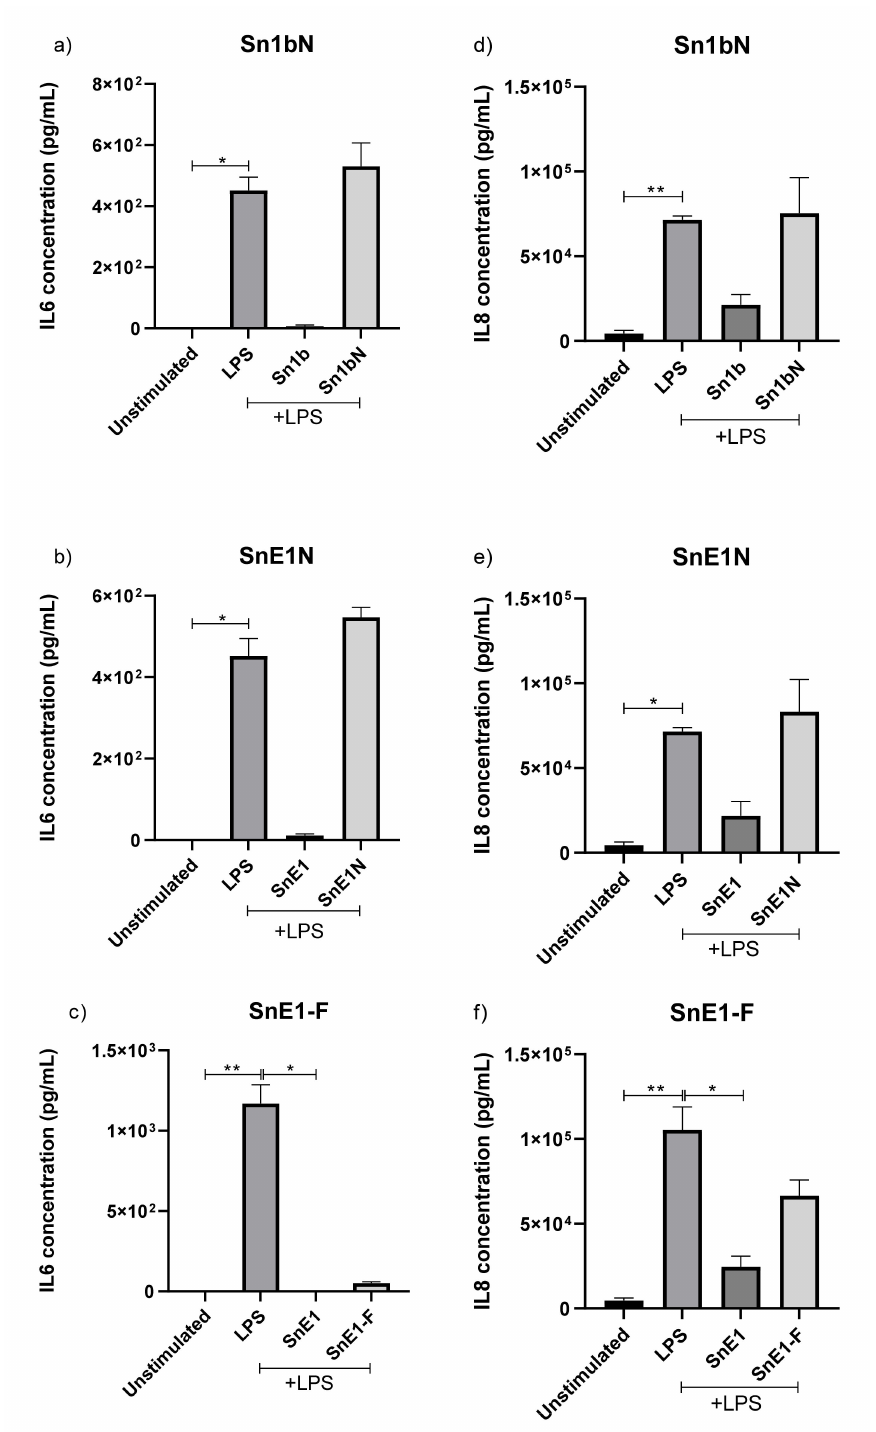
Figure 9. IL-6 and IL-8 concentrations in the supernatant of THP-1 monocyte-derived macrophages following incubation with peptides and LPS. THP-1 monocyte-derived macrophages were incubated with ( a ) Sn1b (1.6 µ M), Sn1bN (1.6 µ M), ( b ) SnE1 (1.2 µ M), SnE1N (1.2 µ M), ( c ) SnE1 (1.2 µ M) and SnE1-F (1.2 µ M) and/or 100 ng/mL of LPS for 16 h. ( a – c ) IL-6 and ( d – f ) IL-8 levels in cell supernatants were then measured via ELISA. Kruskal–Wallis with Dunn’s Multiple Comparison * p < 0.05, ** p < 0.01, n =